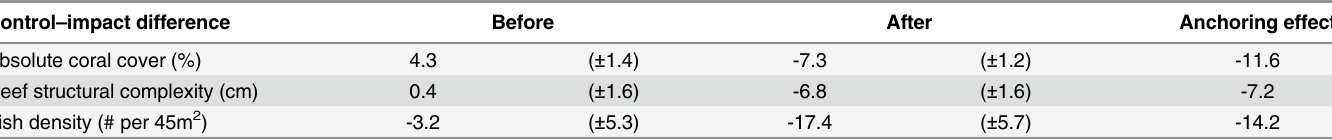
Table 2. Control-impact differences before and after the anchoring event. The raw data for this comparison were simultaneous measurements in the anchor damaged part of the site (impact) and the undamaged area (control). Displayed are means ( ± SE) of the difference between the paired measurements. Calculation of the anchoring effect is explained in the